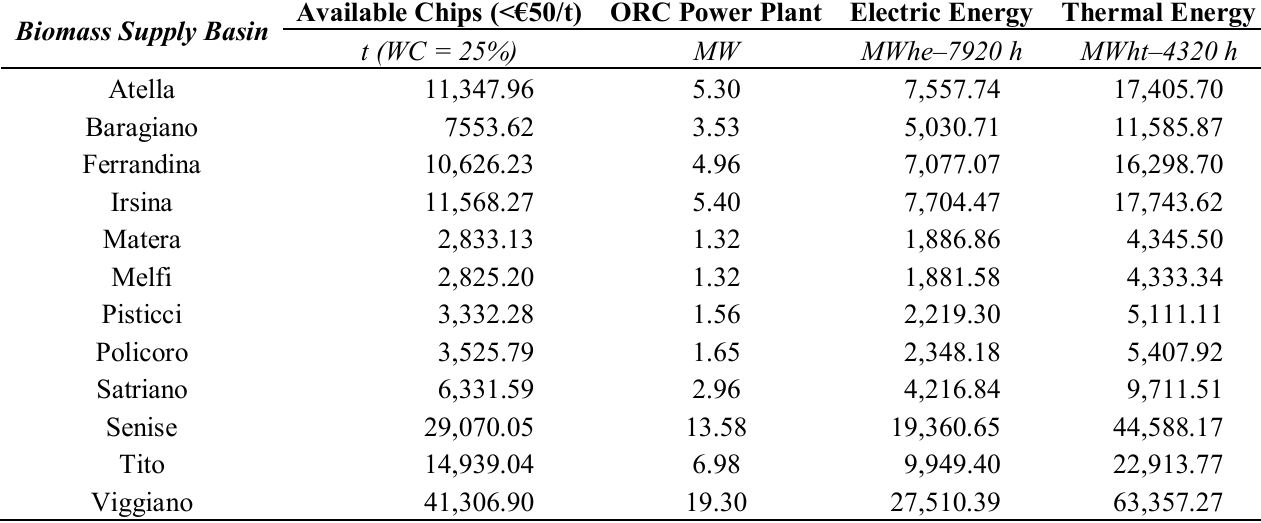
Table 6. Estimated power plant size for each supply